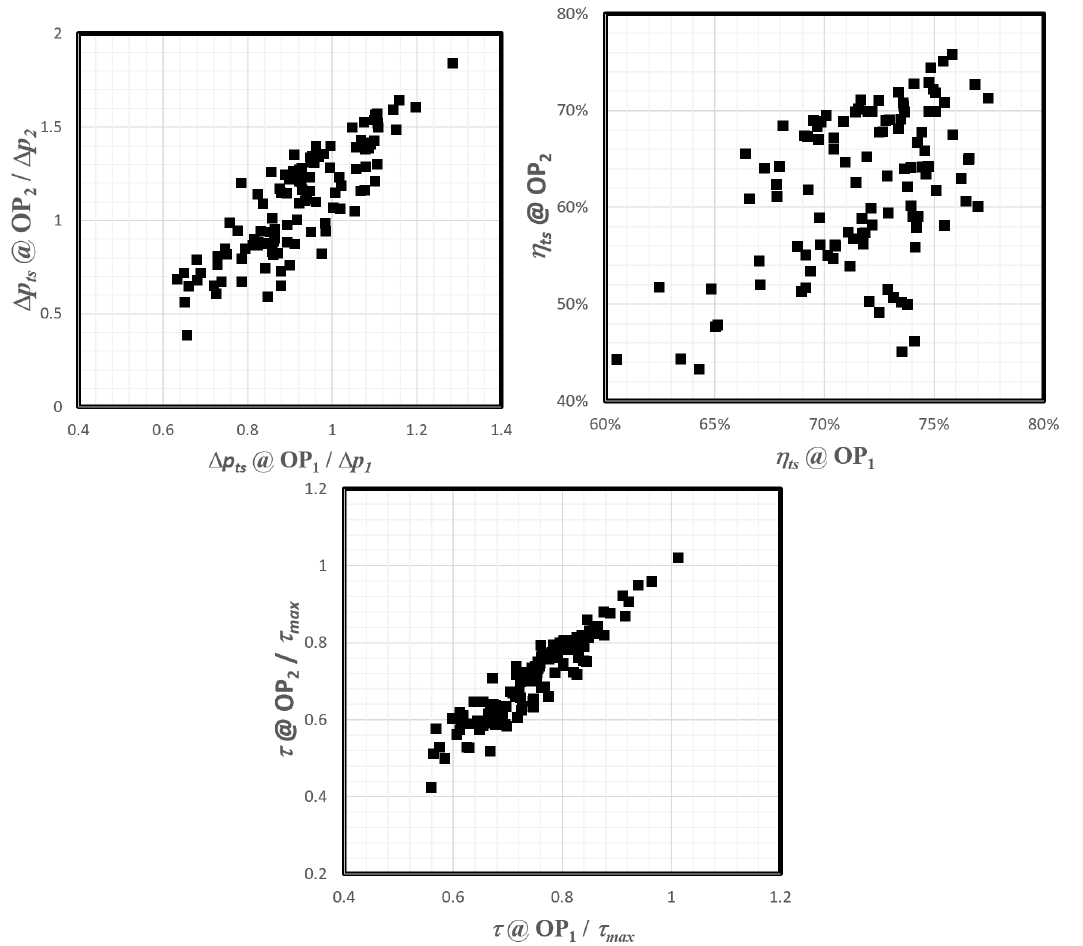
Figure 10. CFD results (pressure rise, efficiency and torque) of DOE designs.